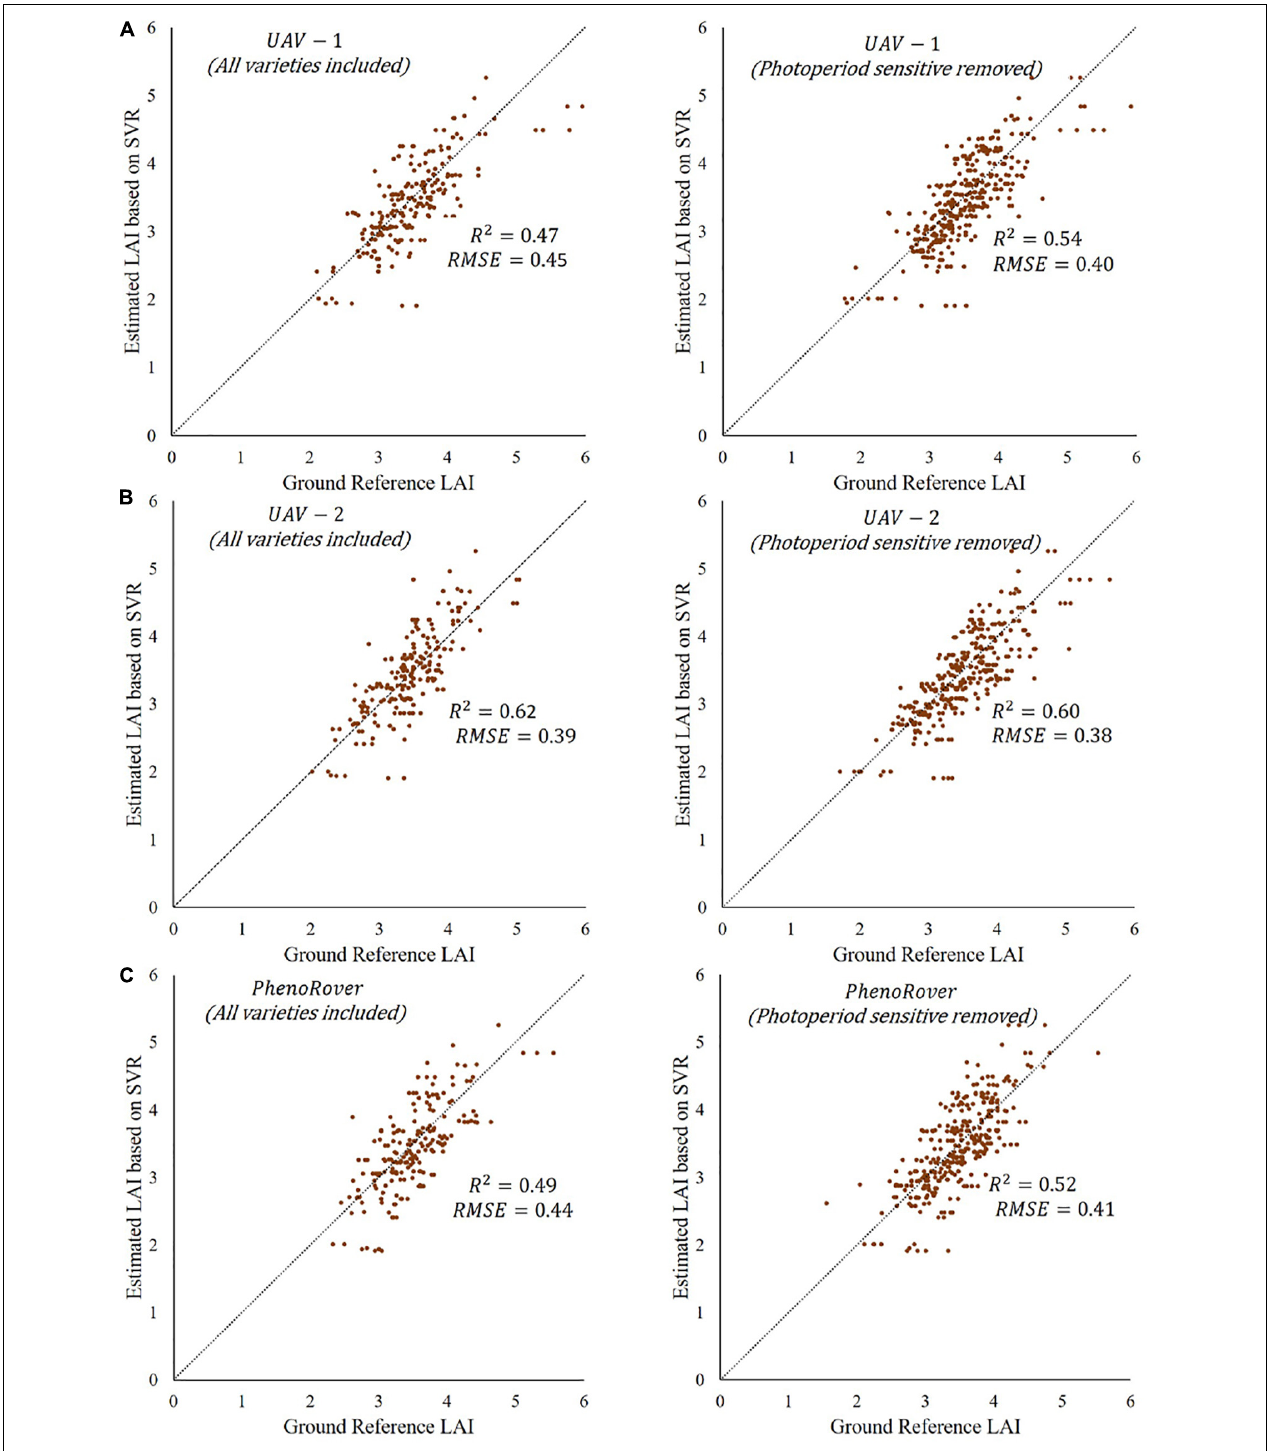
FIGURE 12 | Predictions based on SVR RBF models showing R 2 values and RMSE at midseason (7/20/2020) before and after removing photosensitive varieties for three platforms: (A) UAV-1, (B) UAV-2, and (C) PhenoRover.